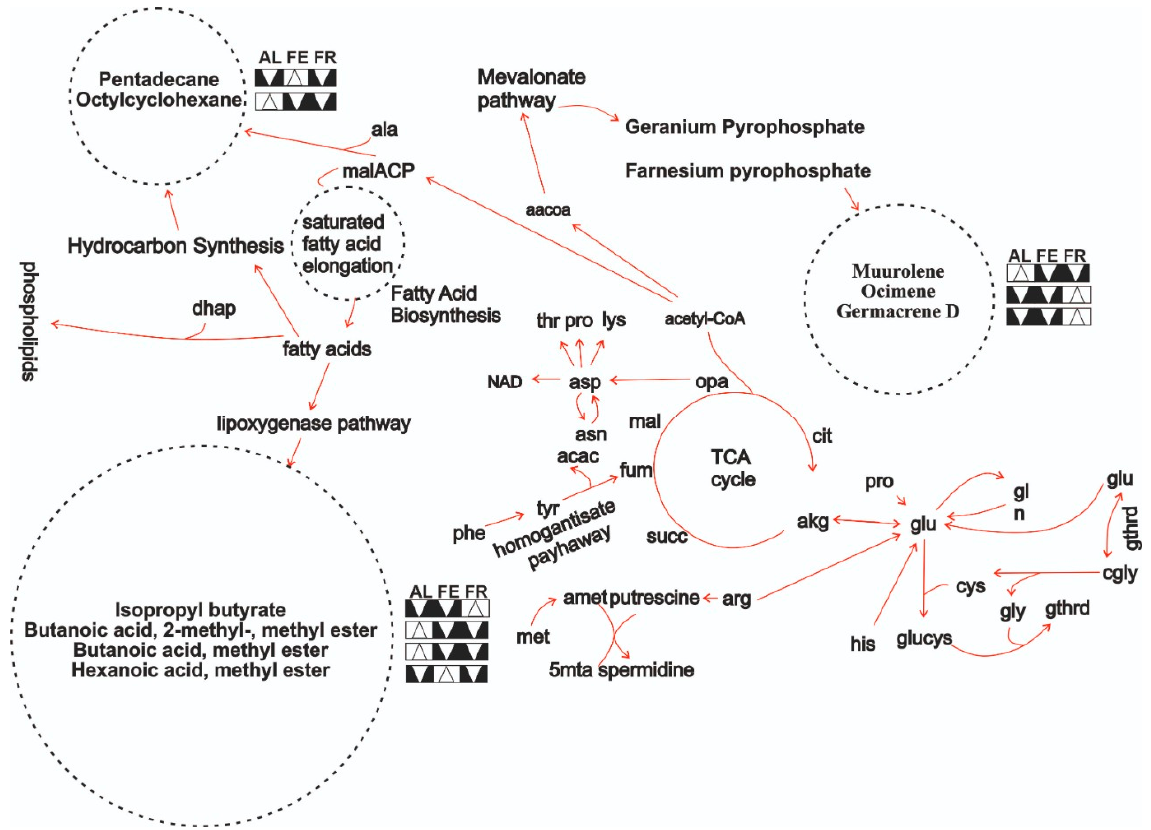
Figure 3. Metabolic pathways for the synthesis of the main VOCs detected in the Variable importance in projection (VIP) graph for fruits of the three strawberry varieties during the seven stages of maturation. The nine most important metabolites are classified into three chemical families; Compounds with white triangles facing upwards represent the highest total concentrations for the variety indicated on the labels, on the other hand, compounds with a black triangle facing downwards represent a lower total concentration of the metabolite for the variety indicated on the labels.